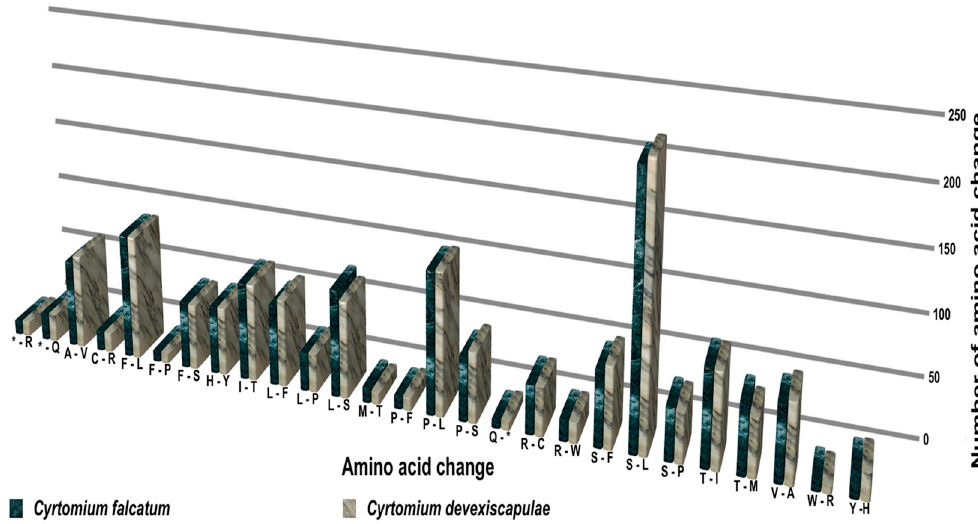
Figure 7. The number of amino acid changes in the cp genomes of C. falcatum and C. devexiscapulae . The green column indicates the amino acid changes that occurred in the protein ‐ coding genes of C. falcatum , whereas the gray column indicates the amino acid changes that occurred in the protein ‐ coding genes of C. devexiscapulae .